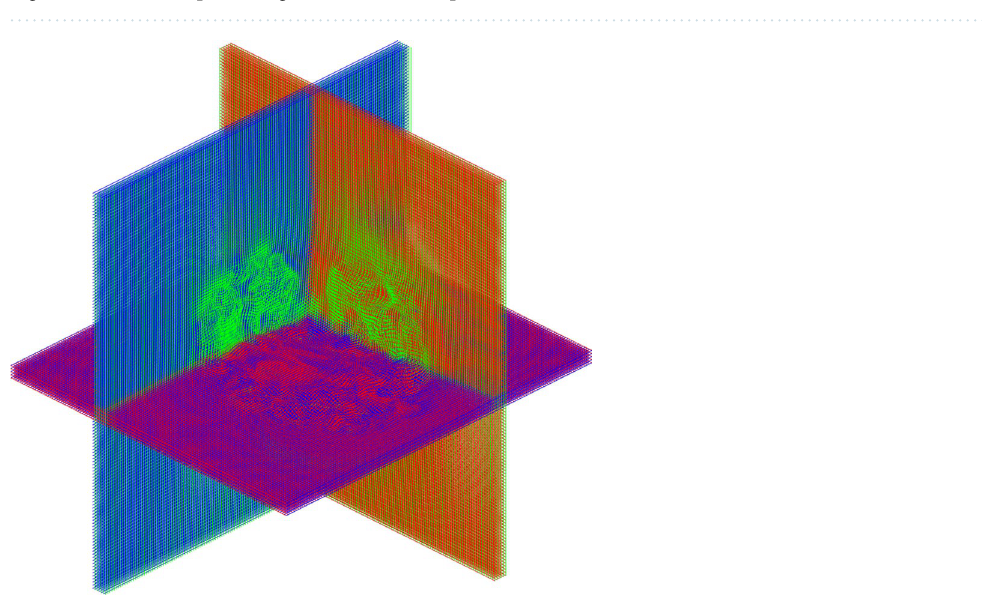
Figure 16. Actual 3D volumetric SYMREG warping grid used in the registration of Fig.